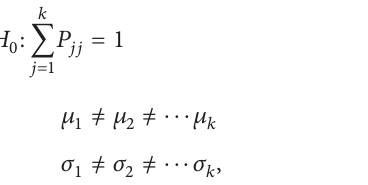
Table 3 presented Wald test statistics 𝑊 𝑃 and 𝑊 𝜇 . At 𝛼